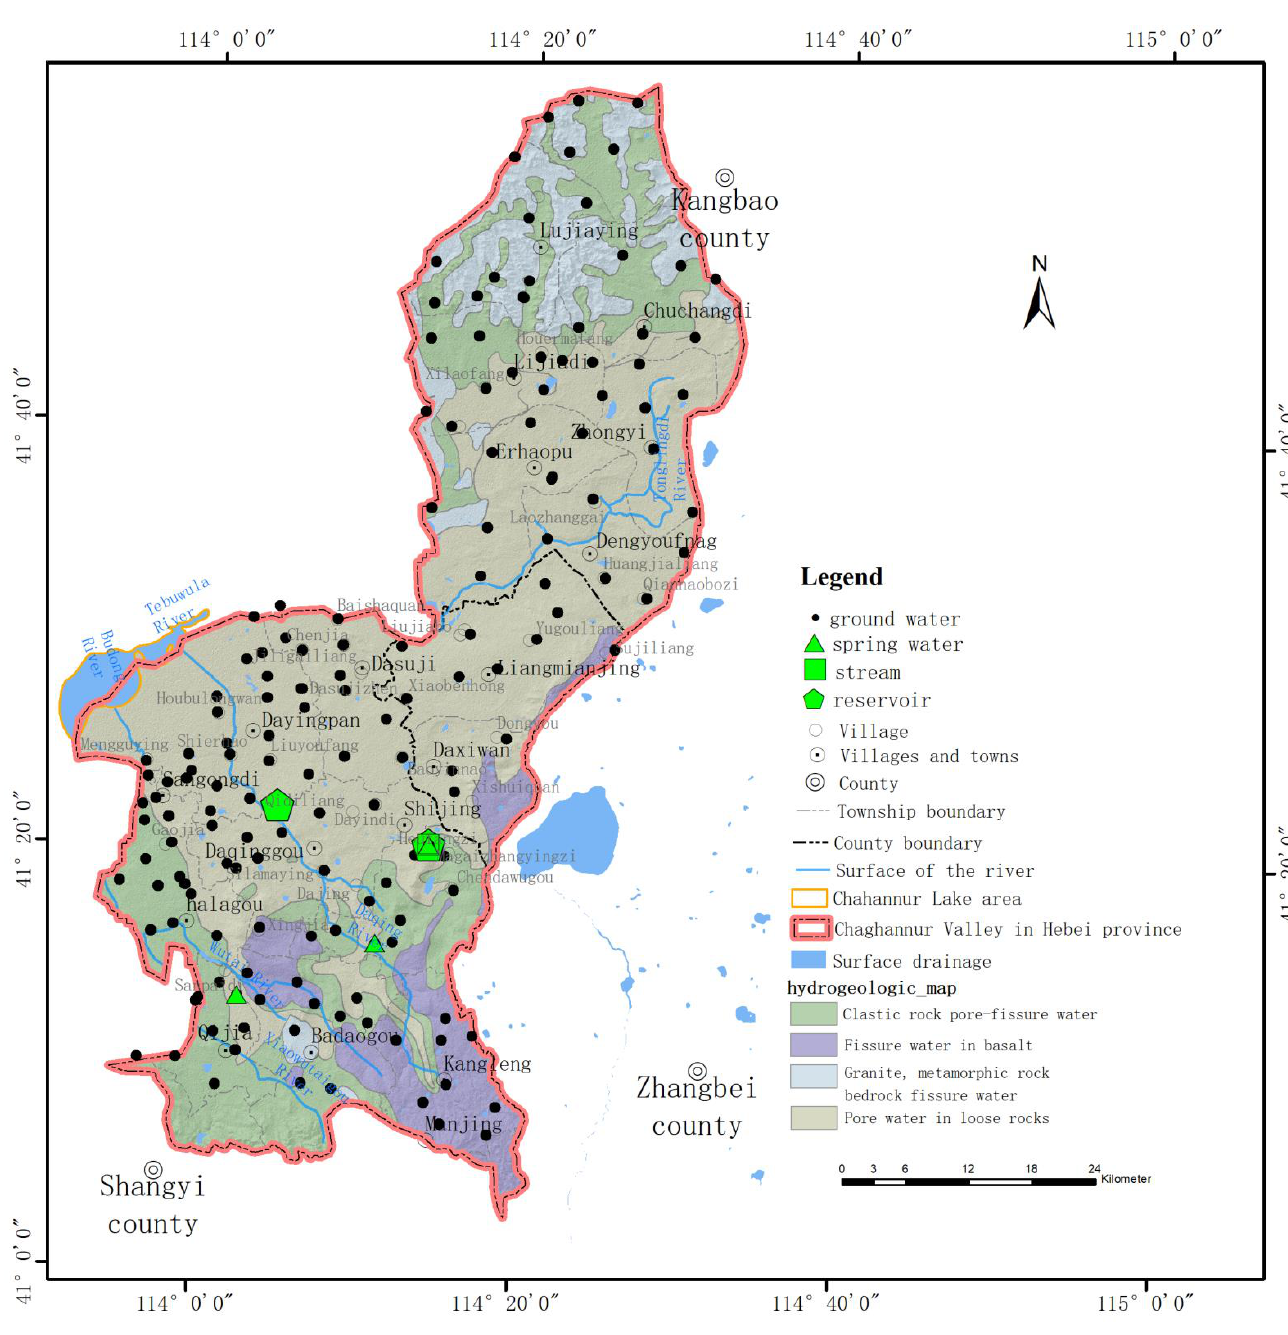
Figure 1. Bitmap of hydrochemical sampling sites in the Chahannur Basin.